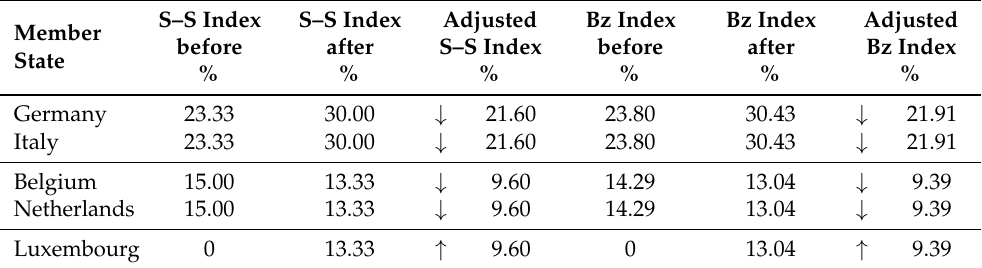
Table 3. The effect of France’s departure from the Council of Ministers in 1958, Shapley–Shubik (S–S) and Banzhaf